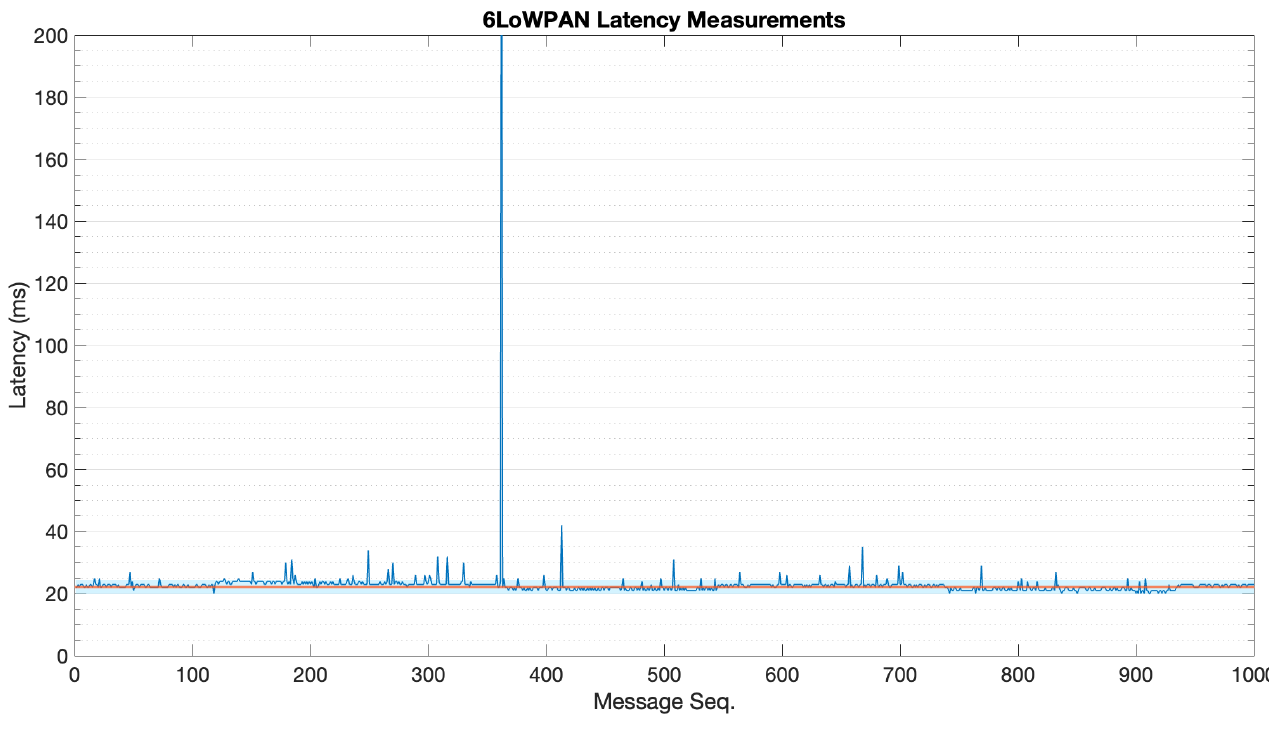
Figure A2. Latency plot for 6LoWPAN.